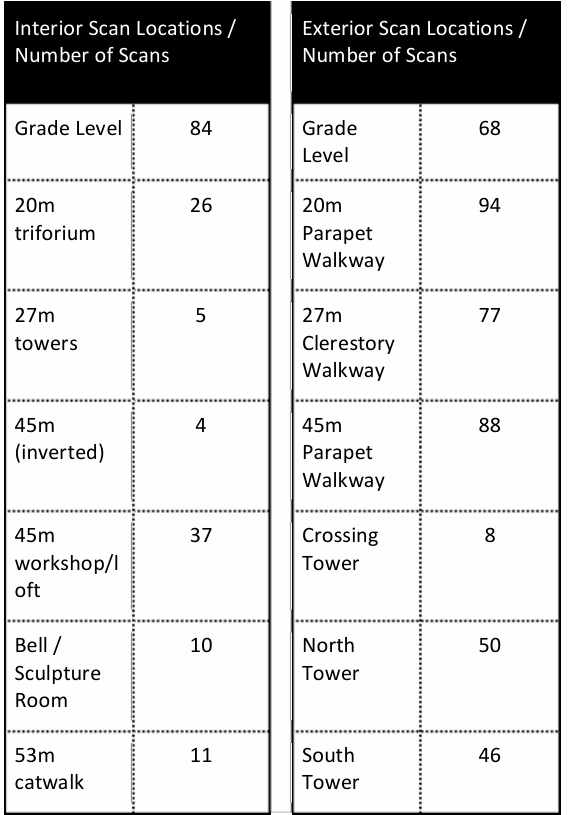
Figure 1: Location and number of terrestrial scan stations,